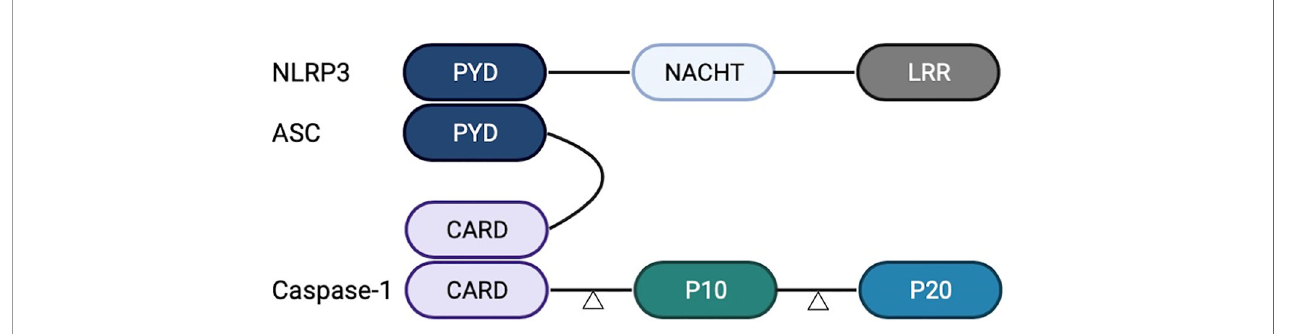
FIGURE 1 | Structure of nucleotide-binding oligomerization domain-like-receptor family pyrin domain-containing 3 (NLRP3) in fl ammasome. NLRP3 in fl ammasome comprises a leucine-rich repeat (LRR) domain, an N-terminal Pyrin domain (PYD), and a central adenosine triphosphatase (ATPase) domain known as NACHT. Caspase-1 comprises CARD and two subunits, p10 and p20. NLRP3 and ASC interact with their respective PYDs. ASC and Caspase-1 interact with their respective